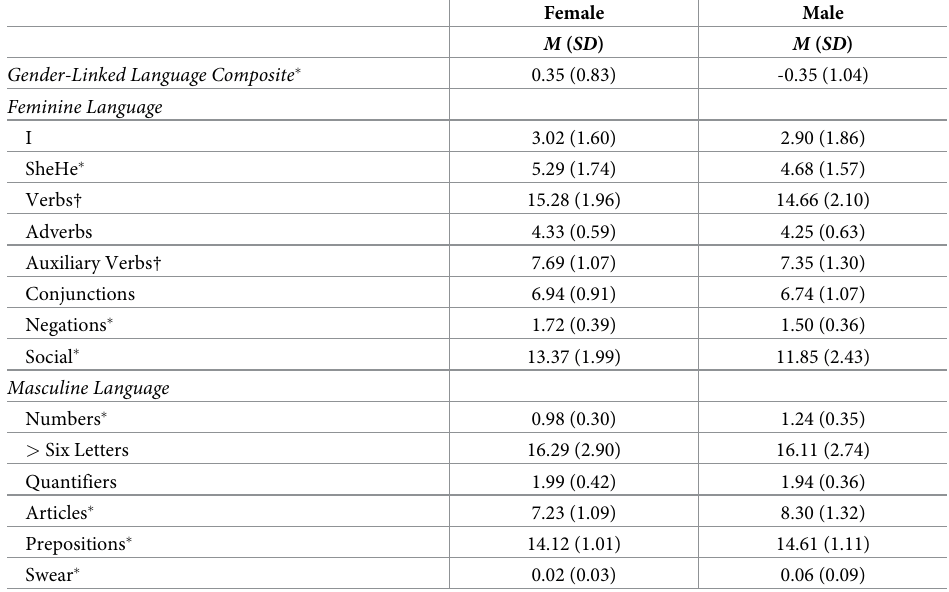
Table 3. Mean differences of language use in novels across male and female authors.